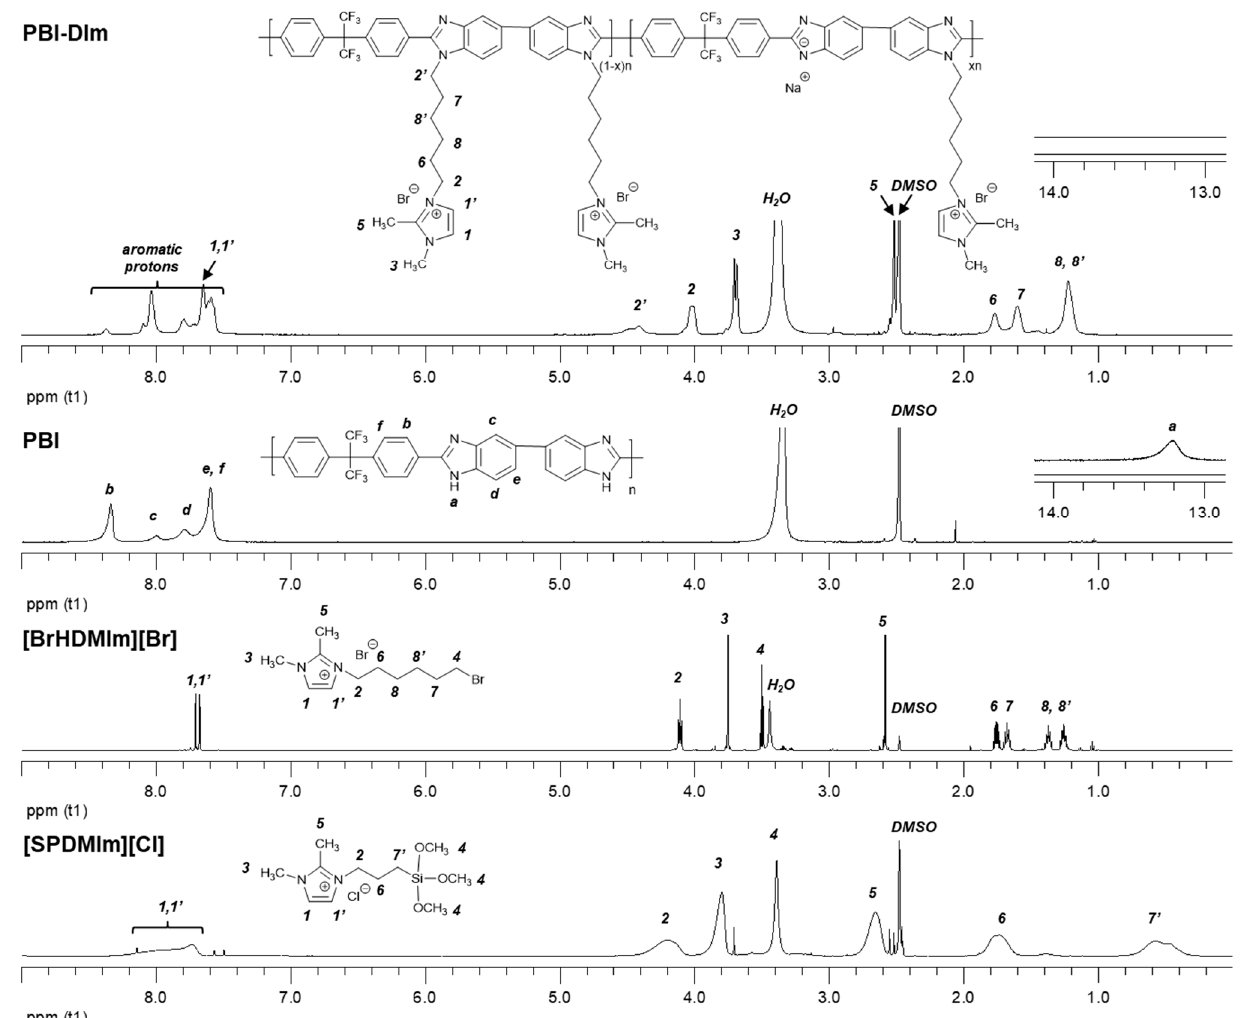
Figure 1. 1 H NMR spectra of [SPDMIm] [Cl], [BrHDMIm] [Br], PBI, and PBI-DIm.